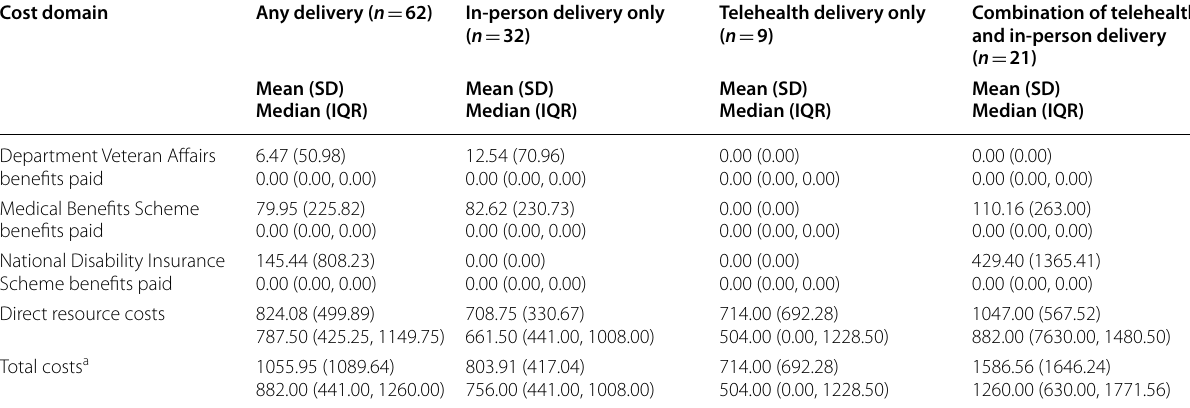
a Total cost includes the sum of all costs: Department of Veteran Affairs benefits paid, Medical Benefits Scheme benefits paid, National Disability Insurance Scheme benefits paid and direct resource